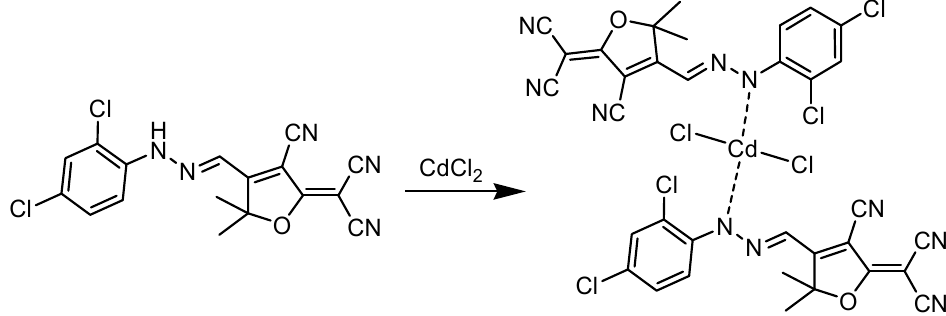
Figure 9. Proposed mechanism for the formation of hydrazone–cadmium complex.